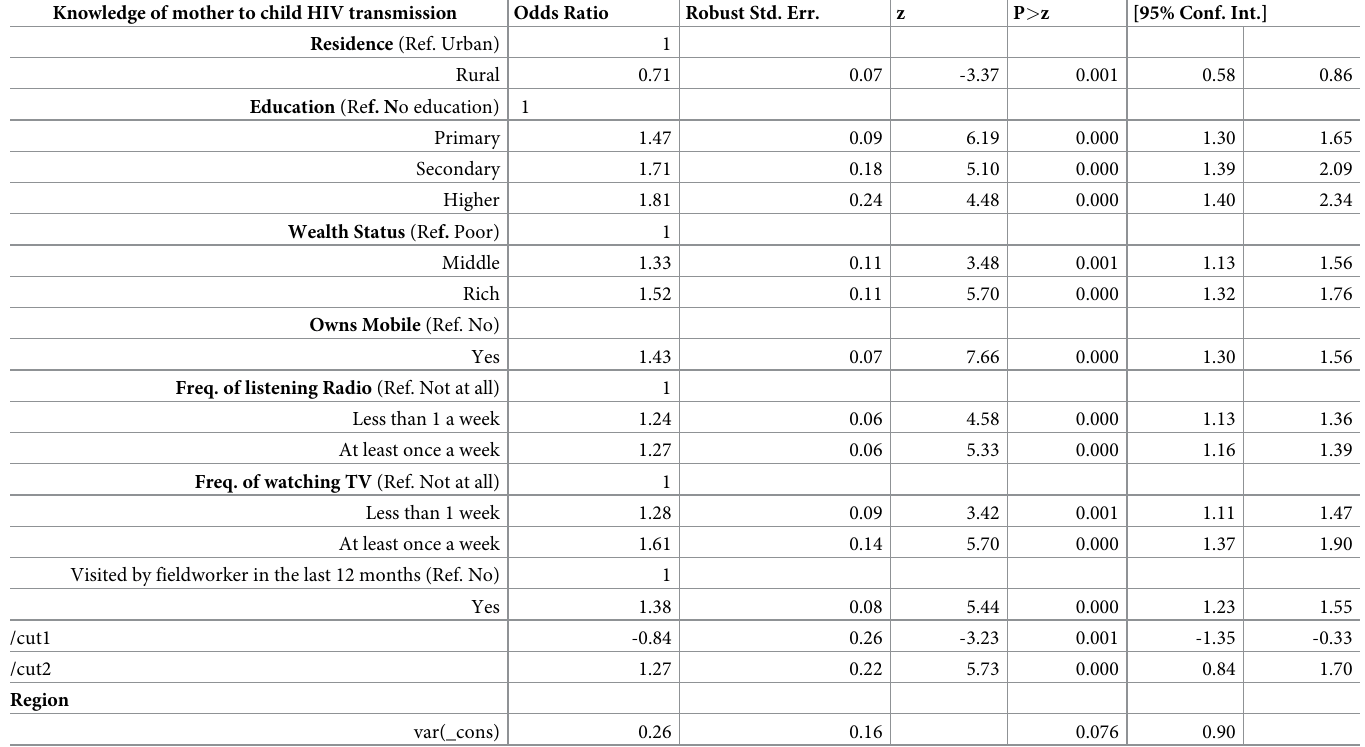
Table 3. Factors associated with mother-to-child HIV transmission knowledge among reproductive-age women in Ethiopia, EDHS 2016. Knowledge of mother to child HIV transmission